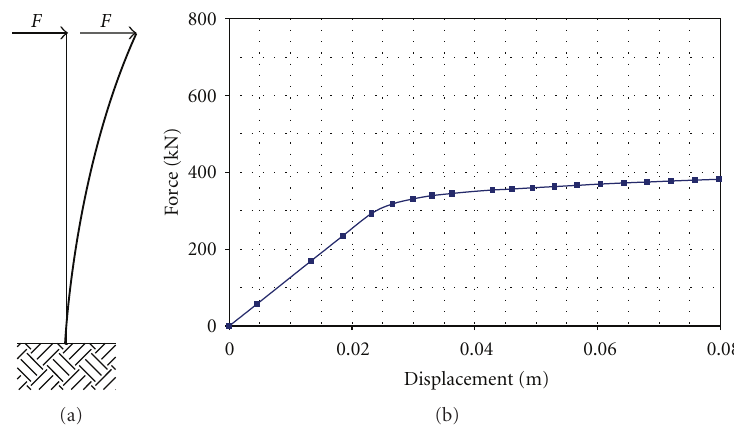
Figure 7: Piers behaviour in the longitudinal direction: (a) deflection shape; (b) force-displacement curve.